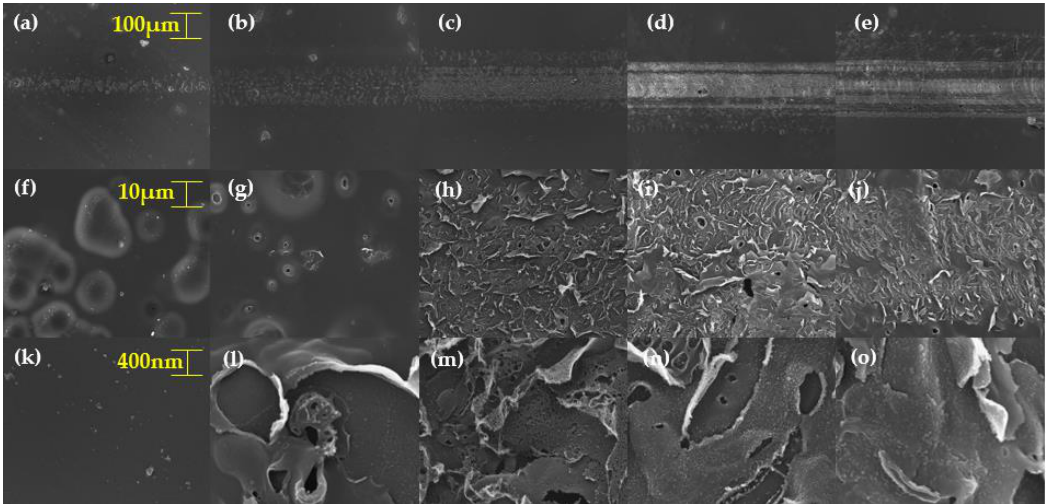
Figure 4. FE-SEM images of pulse-overlapped line patterns fabricated: ( a , f , k ) at 100 mm/s, ( b , g , l ) at